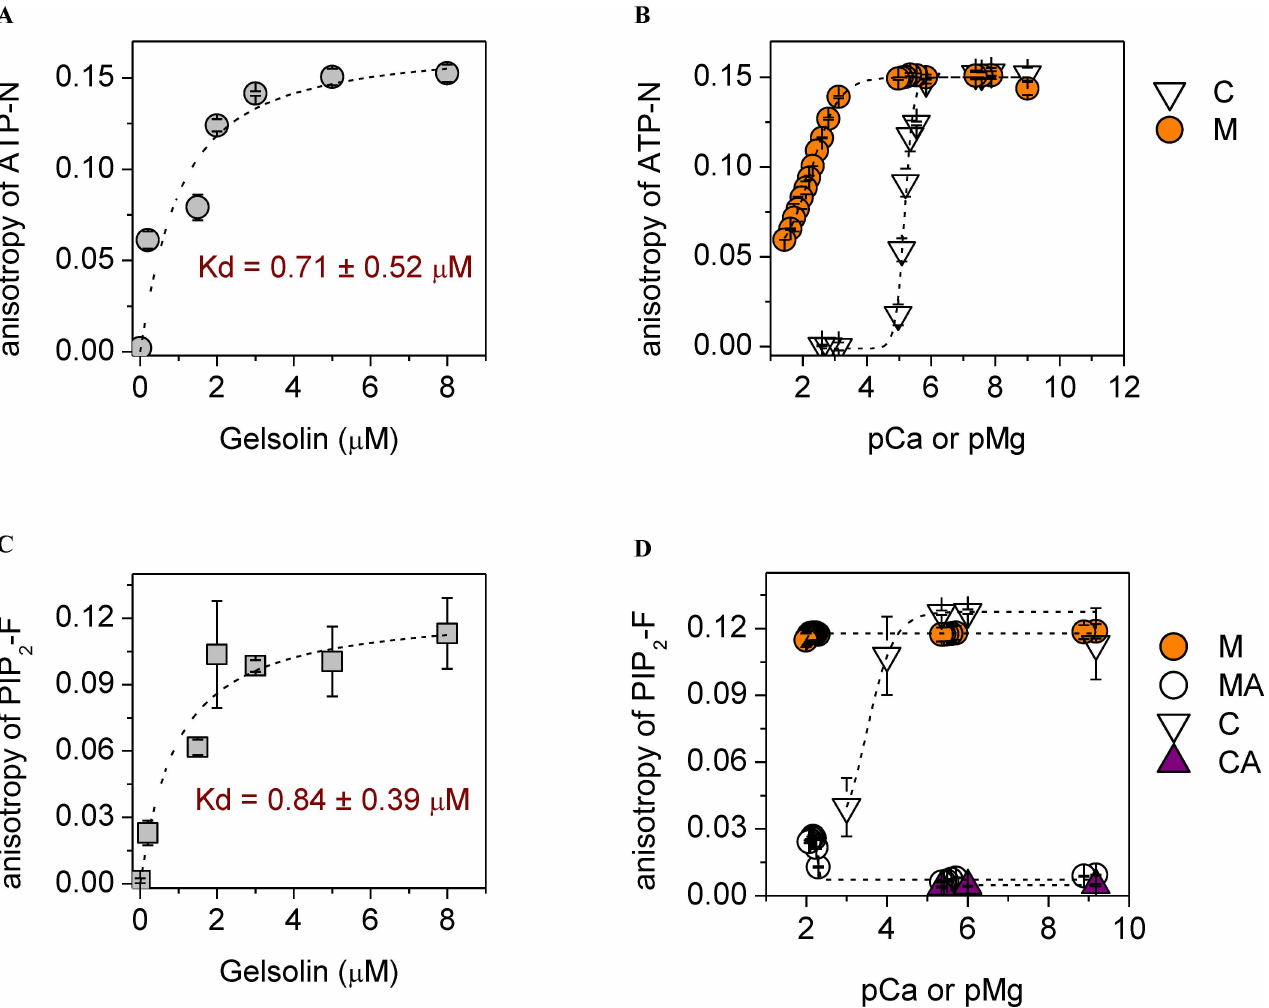
Fig 1. The interplay between calcium, magnesium, ATP and PIP 2 for binding to gelsolin. (a) In the absence of cations, the anisotropy of ATP-N (0.5 μ M) increased and saturated by ~ 5 μ M gelsolin. Dashed line shows the fit to the data (Eq 2). (b) Micromolar calcium levels (C, open triangles, inflection point at pCa 5.2) or millimolar magnesium levels (M, orange circles, inflection point at pMg 2.3) were able to reduce the anisotropy of ATP-N (0.5 μ M) in the presence of gelsolin (5 μ M), indicating the dissociation of ATP-N from gelsolin. Dashed line indicates sigmoidal fitting. (c) In the absence of cations, the anisotropy of PIP 2 - F (0.5 μ M) increased and reached steady-state at ~ 5 μ M gelsolin, indicating saturation of binding. Dashed line shows the fit to the data (Eq 2). (d) The anisotropy of PIP 2 -F (0.5 μ M) in the presence of gelsolin (5 μ M) was not changed on titration with magnesium (M, orange circles), but inclusion of 0.5 mM ATP (MA, white circles) lowered the anisotropy to the value characteristic to free PIP 2 -F, indicating complete dissociation of the gelsolin/PIP 2 -F complex by